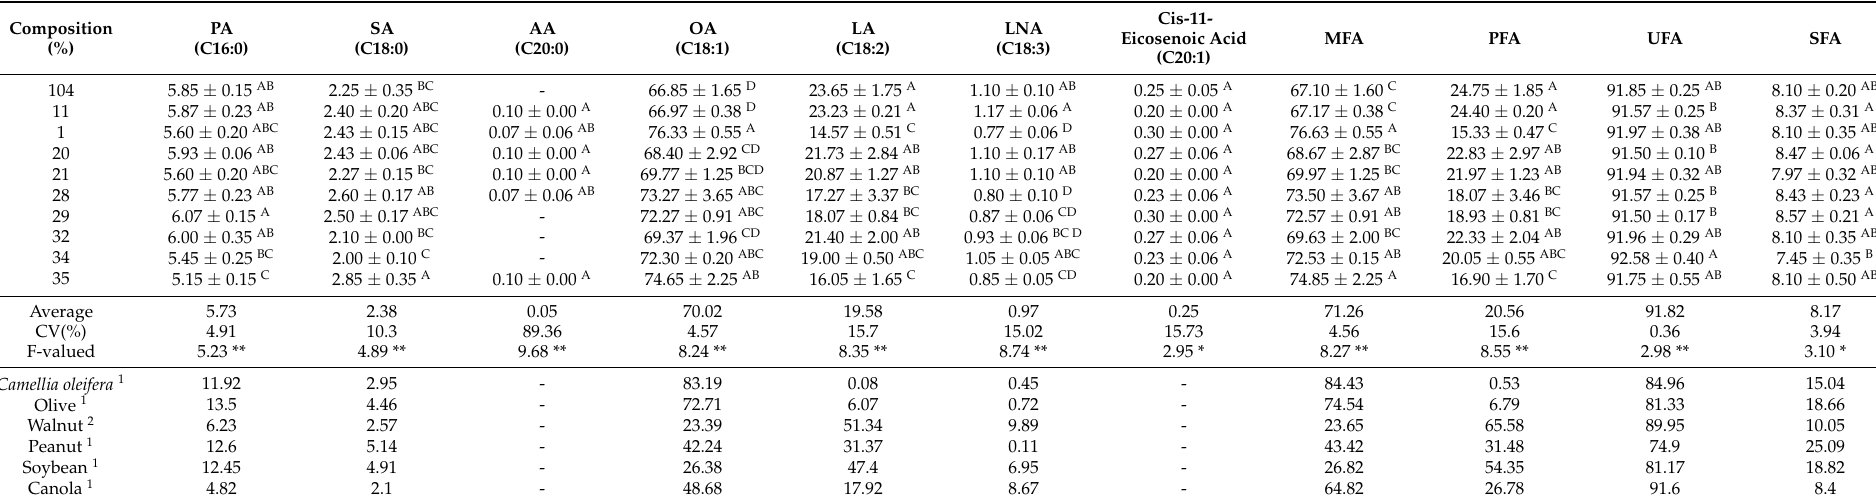
Table 3. Fatty acids composition and content of kernels of 10 pecan varieties and some common oil